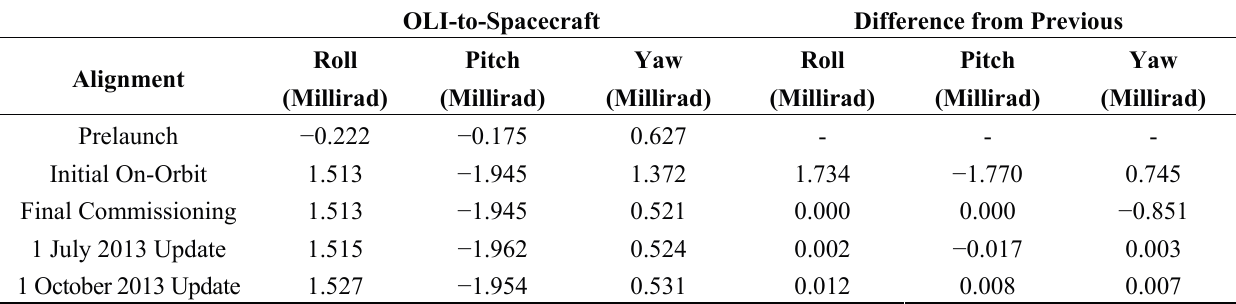
Table 2. OLI-to-spacecraft alignment calibration: prelaunch, on-orbit, and difference from